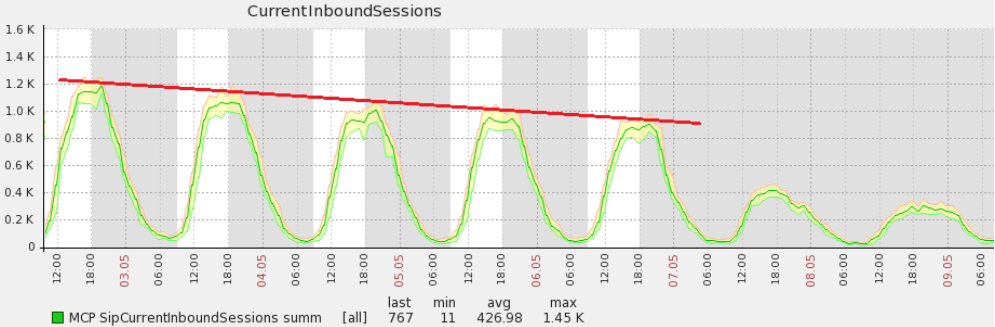
Figure 5. Cyclic user workload with a downgrading prediction trend.